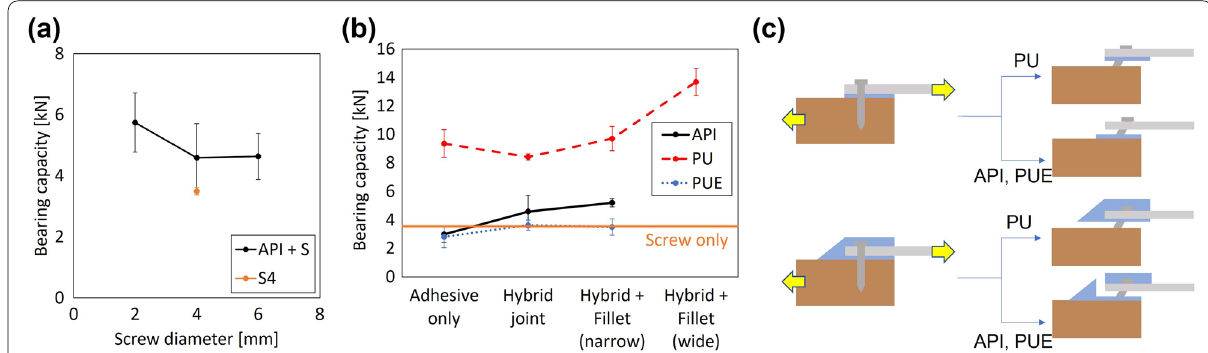
Fig. 7 a Effect of screw diameter on bearing capacity (API); b effect of joint type on bearing capacity; and c failure modes of hybrid joints. Error bars denote standard